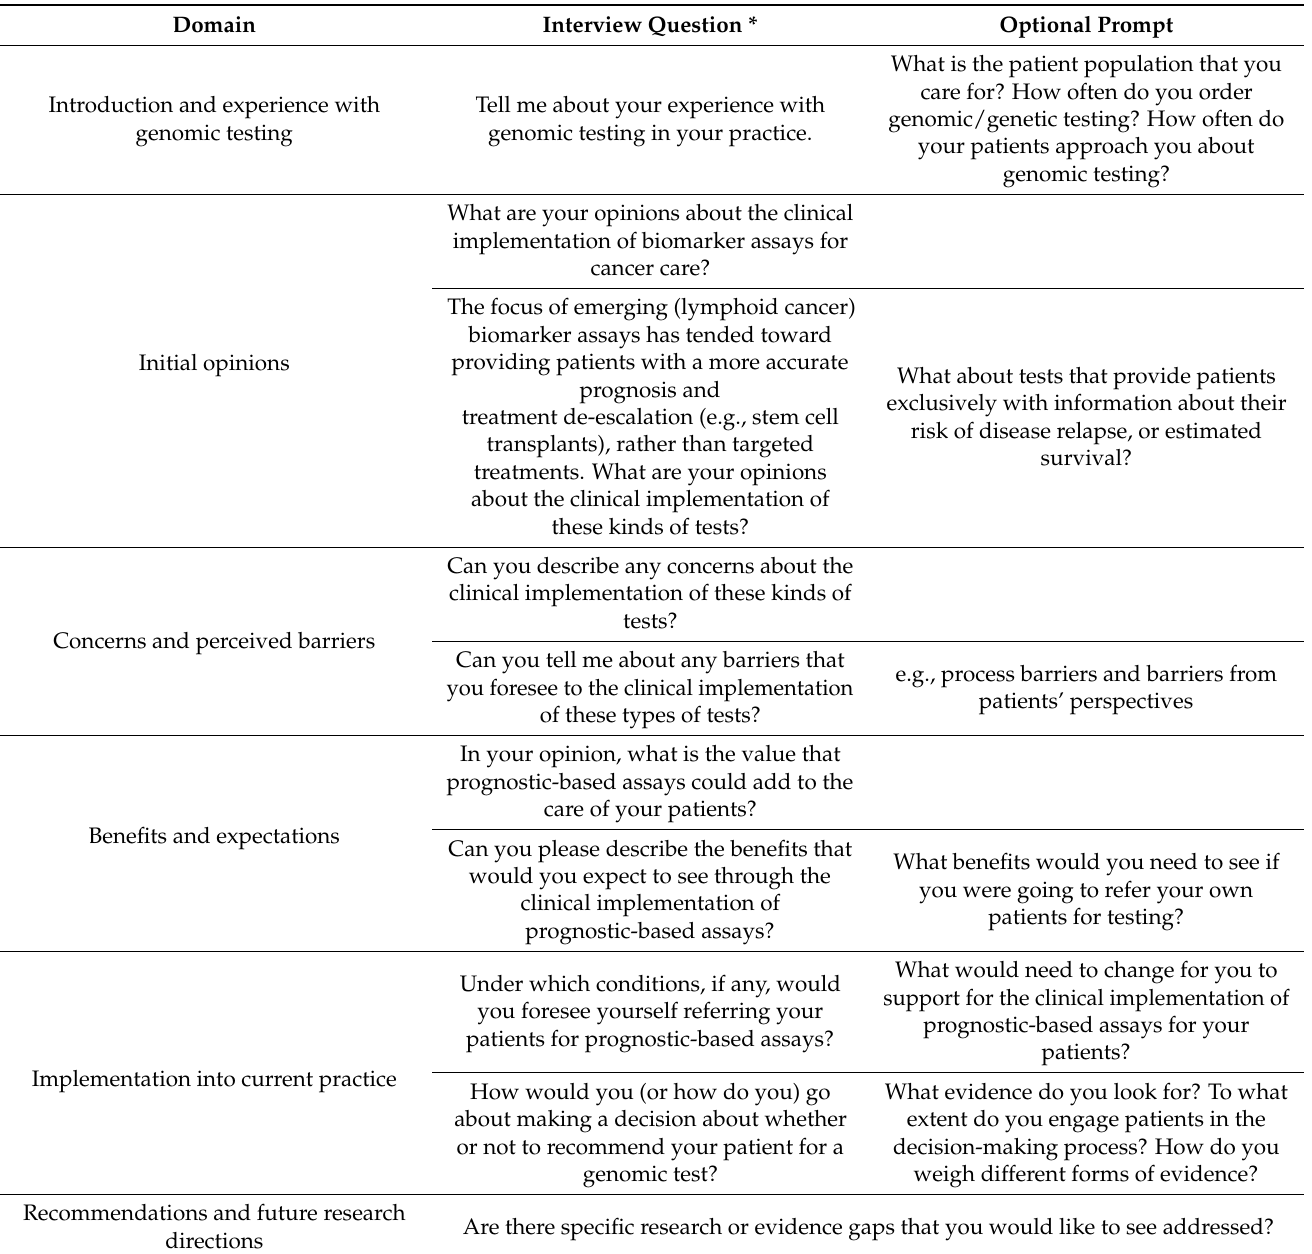
Table A2. Clinician interview